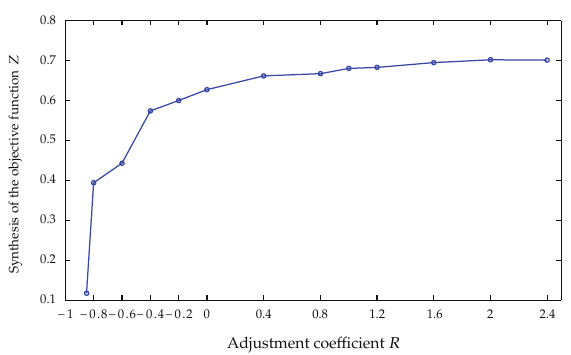
Figure 2: Curve of Z changed with R